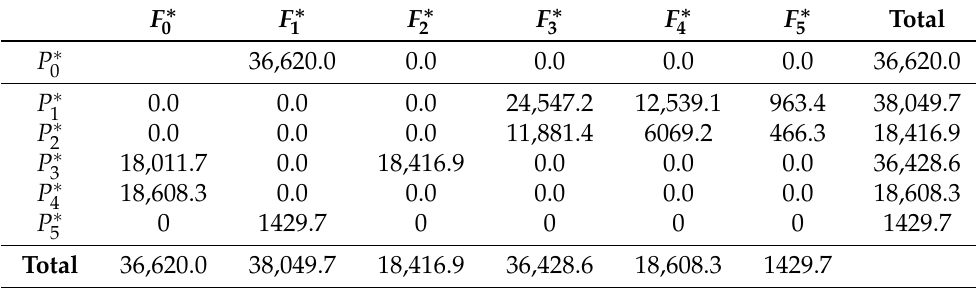
Table 8. Direct Exergy Cost fuel–product table for TGAS